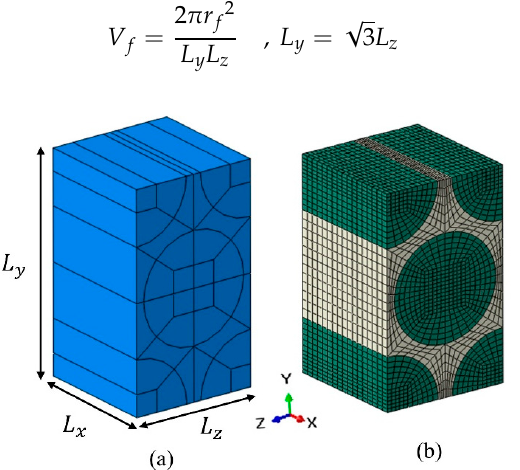
Figure 5. Hexagonal unit cell: ( a ) parameters of a unit cell, ( b ) meshed unit cell.